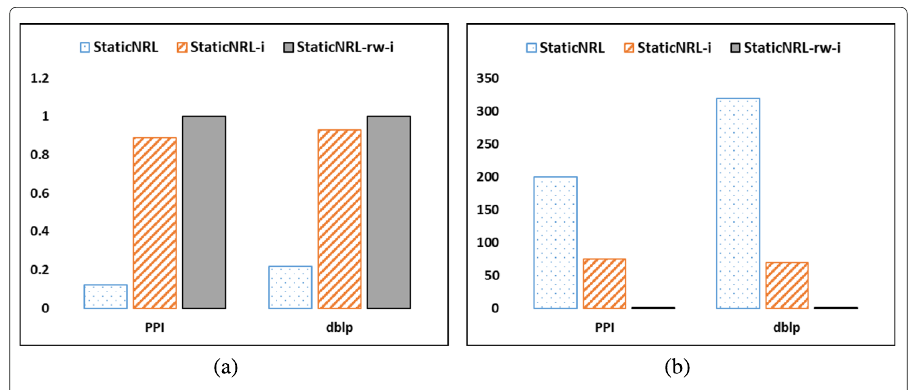
Fig. 1 Instability of the StaticNRL methods. Controlled experiments on running StaticNRL multiple times on the same network depict that the network representations learned are not stable, as a result of random initialization and random walks collected. When any of these random processes are fixed, then the network representations learned become more stable. a cosine similarity and b matrix